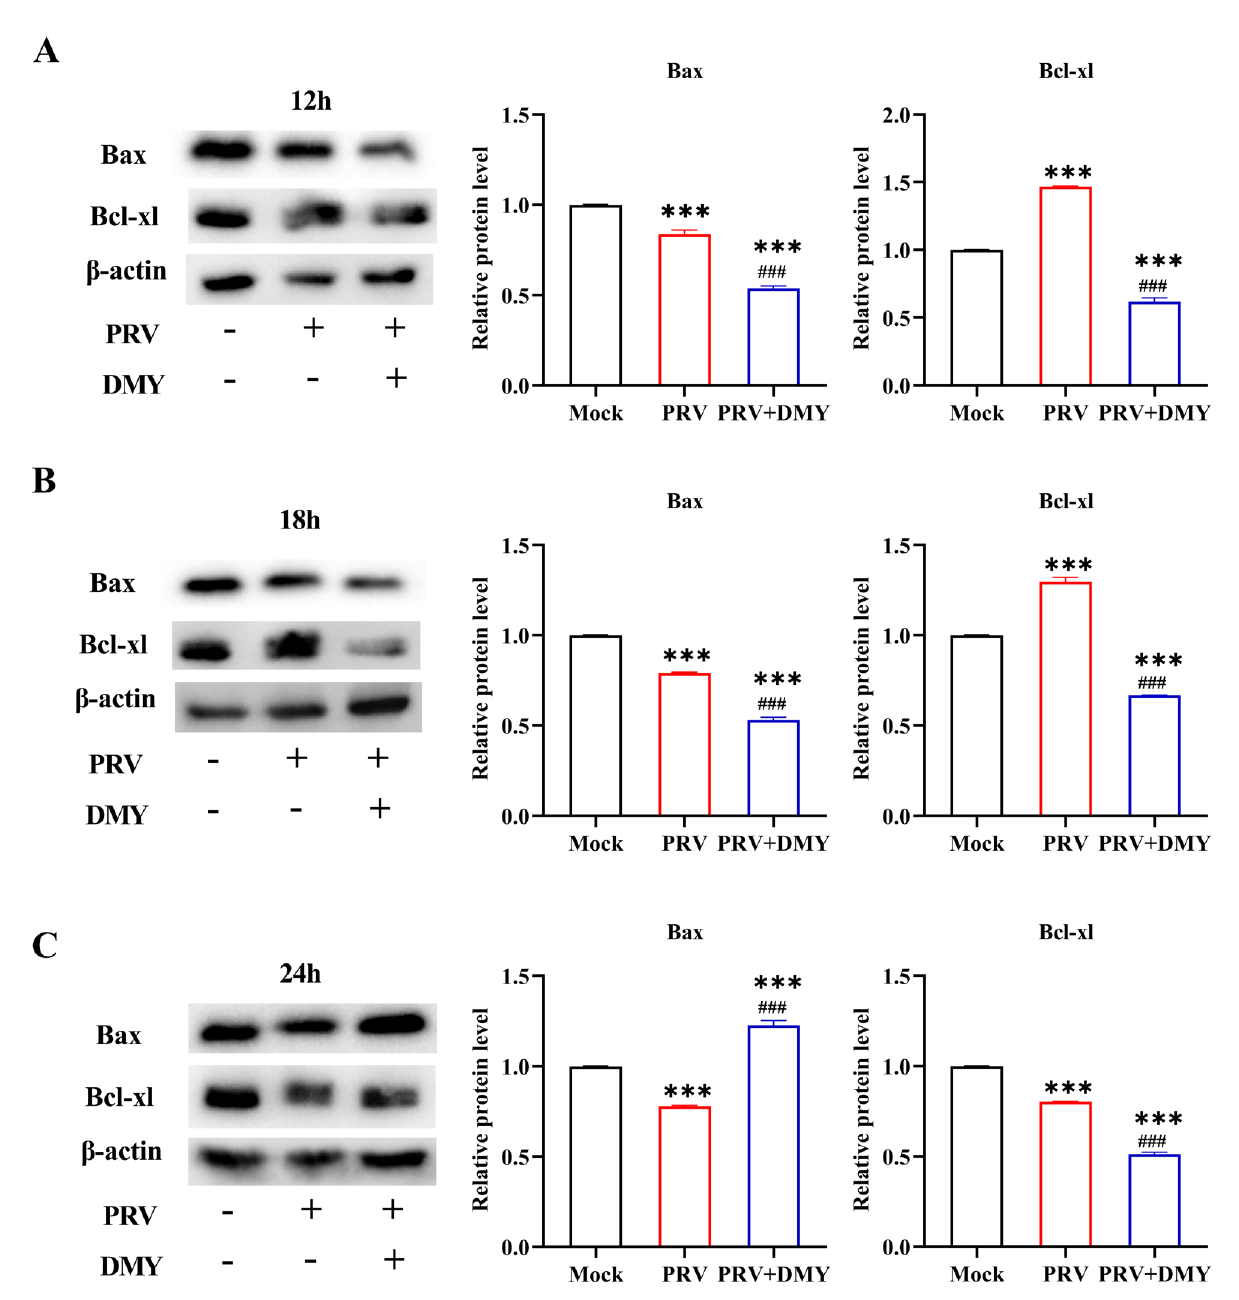
Figure 4. The impact of dihydromyricetin on the expression of the apoptosis-inducing protein at 12 ( A ), 18 ( B ), and 24 ( C ) hpi after infection. In the presence or absence of 500 µ M DMY, PRV (MOI = 1) was added to PK-15 cells. Western blotting was used to identify the expressions of Bax and Bcl-xl. Mock, normal cell groups; PRV, virus-inoculated group; PRV + DMY, virus-inoculated and treated group. Compared with mock group, Symbol *** denotes p < 0.001. Compared with PRV group, symbol ### denotes p < 0.001. The uncropped western blot in Supplementary Material Figure S2.